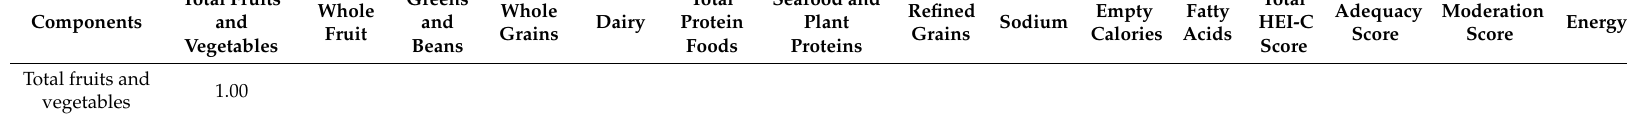
Total Refined Empty Fatty Adequacy Moderation Sodium HEI-C Energy Grains Calories Acids Score Score Score